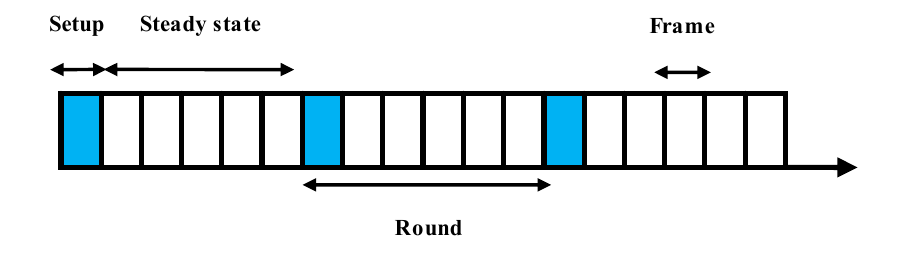
Figure 2. Setup and steady-state phases of EGR. Table 2. Detailed description if the operations in setup and steady state phase.